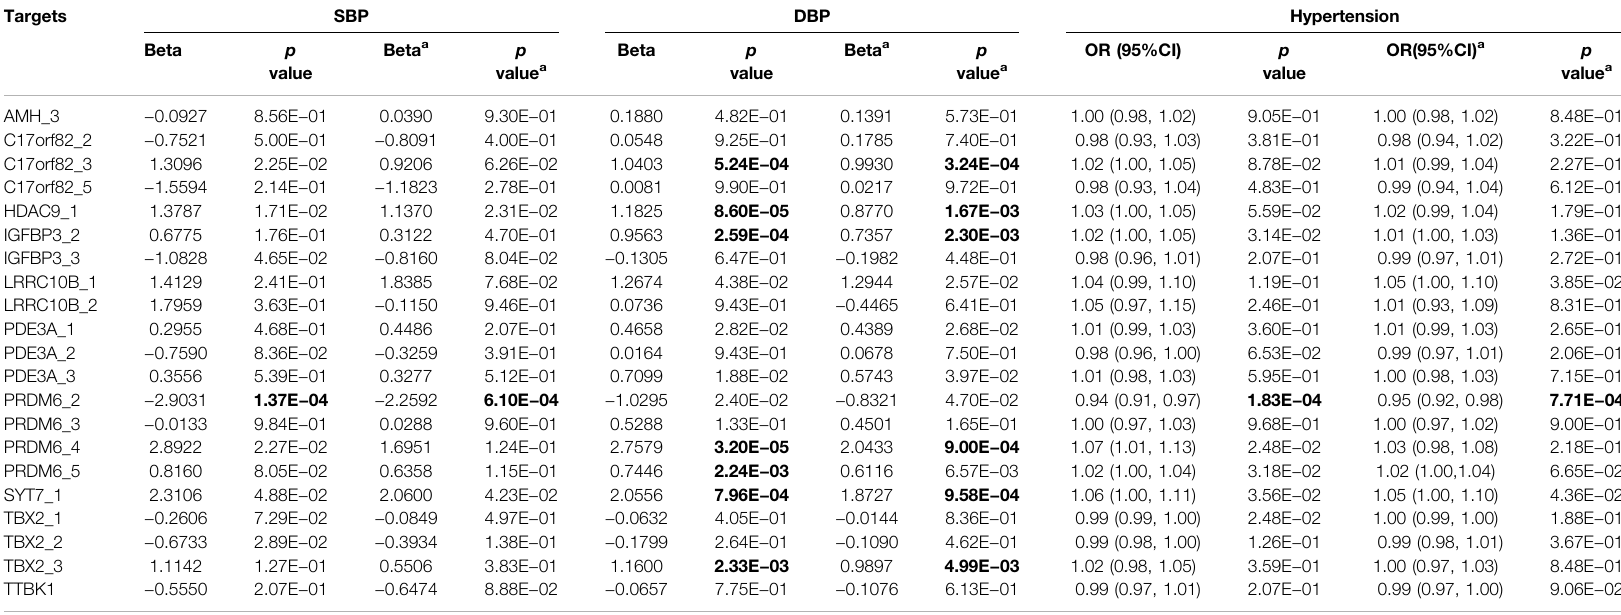
TABLE 3 | The associations between methylation levels of the tested targets and BP and hypertension.